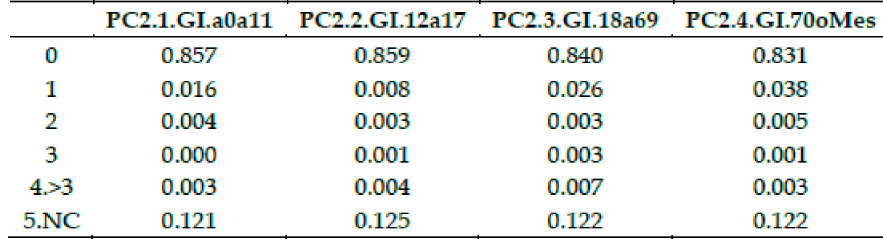
Figure 30. Temporal proportions of PC2.GrauIaCarrec per levels.